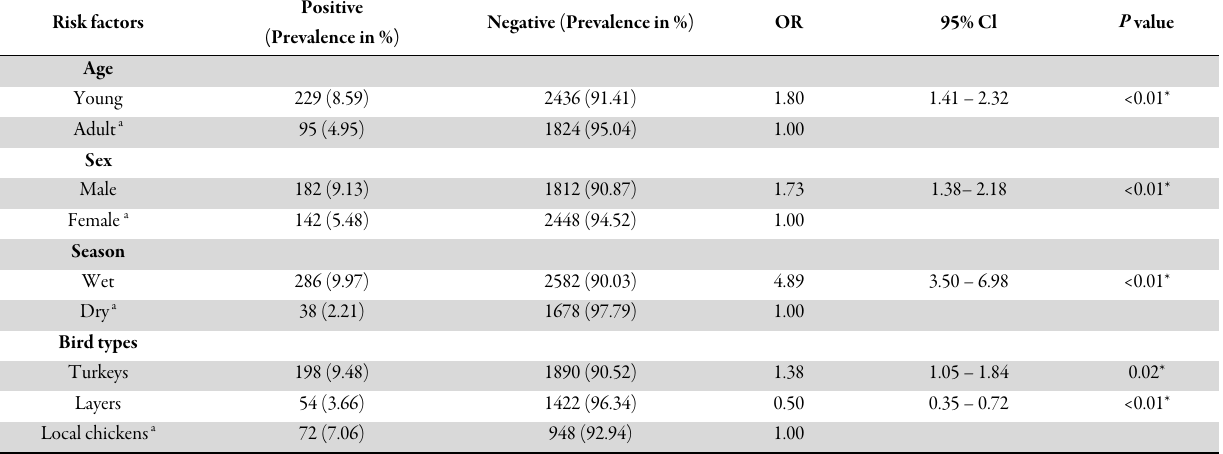
Table 2. Prevalence of avian ectoparasitism and its association with hypothesized risk factors among 4,584 avian species presented in the major Veterinary Hospitals in Osun State from 2006-2015